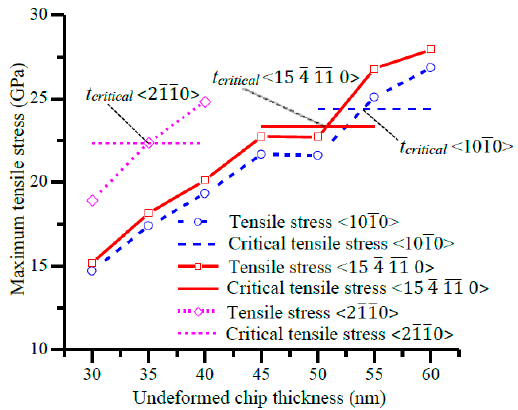
Figure 9. Relationship between tensile stress and undeformed chip thickness.